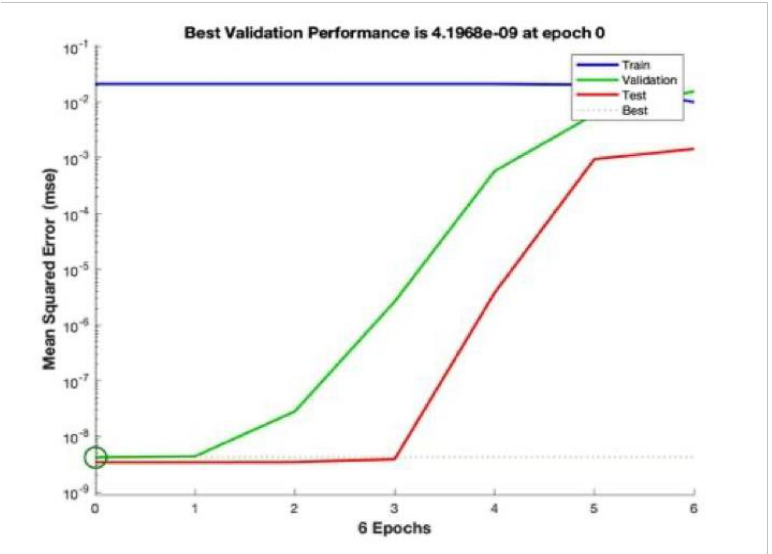
Classification Performance of SubA_5chan_3LRF by BPN Classifier